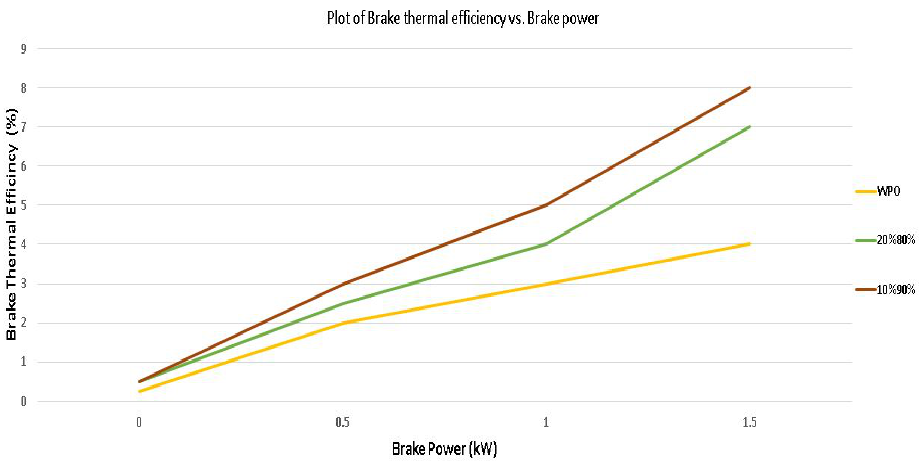
Figure 5. Plot of brake thermal efficiency vs. brake